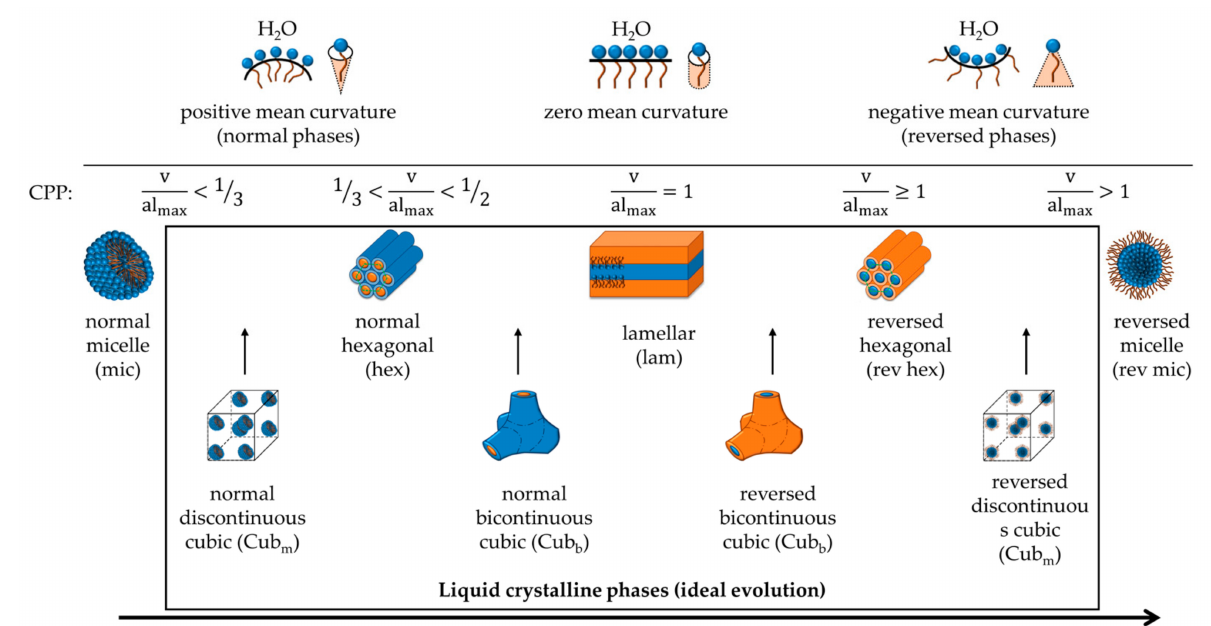
Figure 12. Representation of the surfactant self-assembly evolution at different values of the critical packing parameter (CPP) and the geometrical constraints. The CPP relates the head group area (a), the extended length (l max ) and the volume (v) of the hydrophobic part of a surfactant molecule. The box highlights the various liquid crystalline